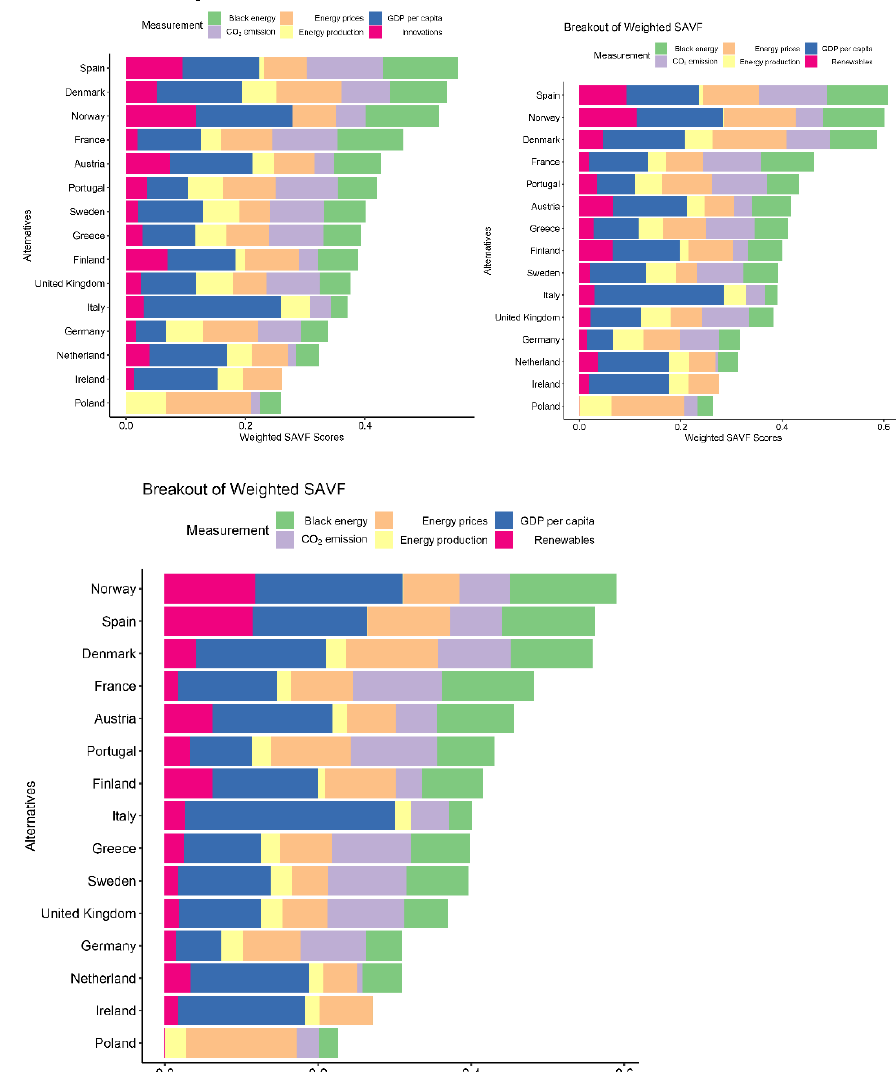
Figure 13. Influence of used variables on the overall SISED for all EU countries in 2019–2021.